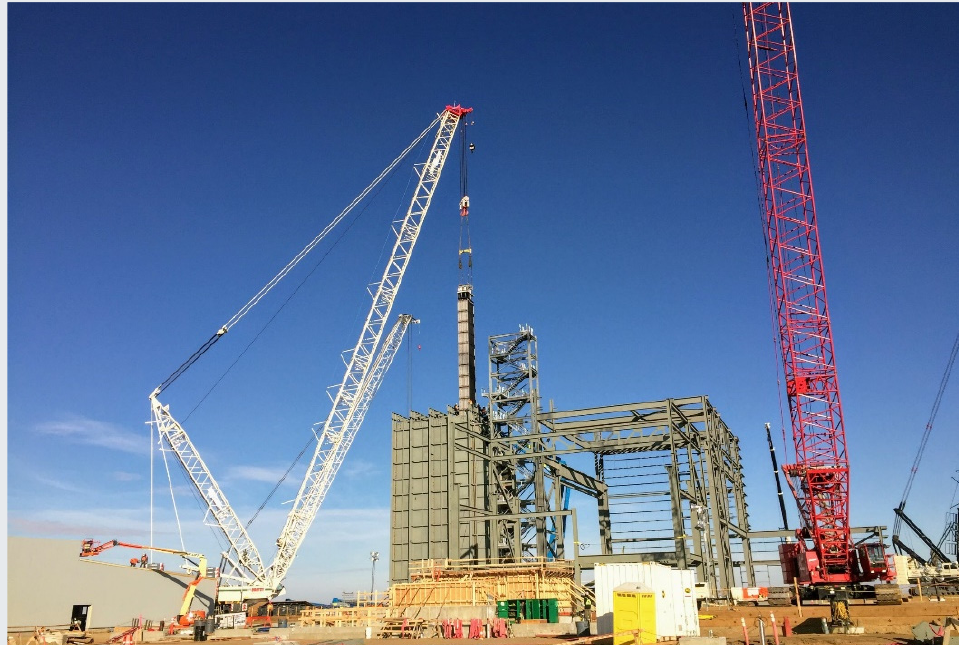
Figure 1. Typical module in industrial projects (photo courtesy of PCL Industrial Management).